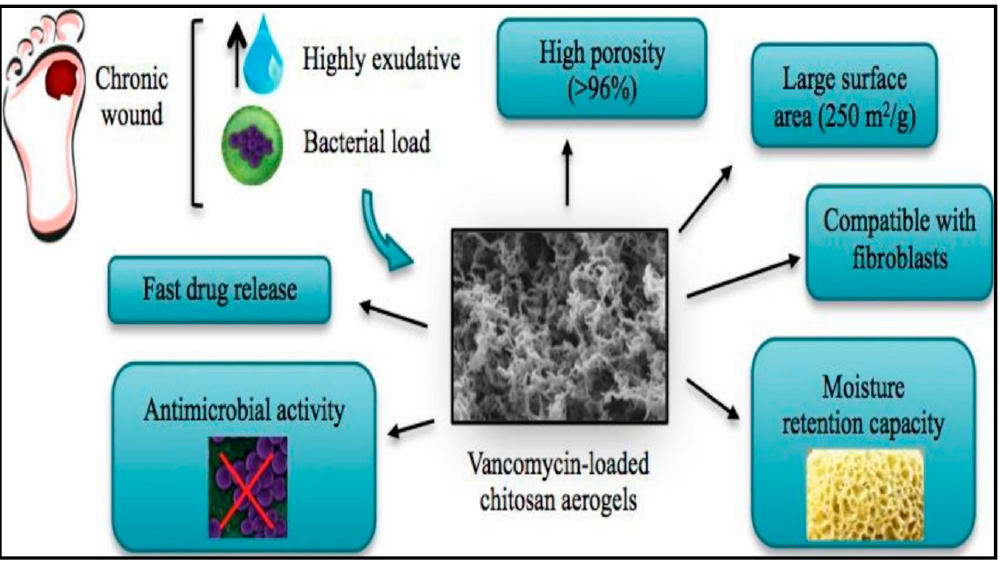
Figure 6. Properties of vancomycin-loaded chitosan aerogels, adapted from López-Iglesias et al. [105].